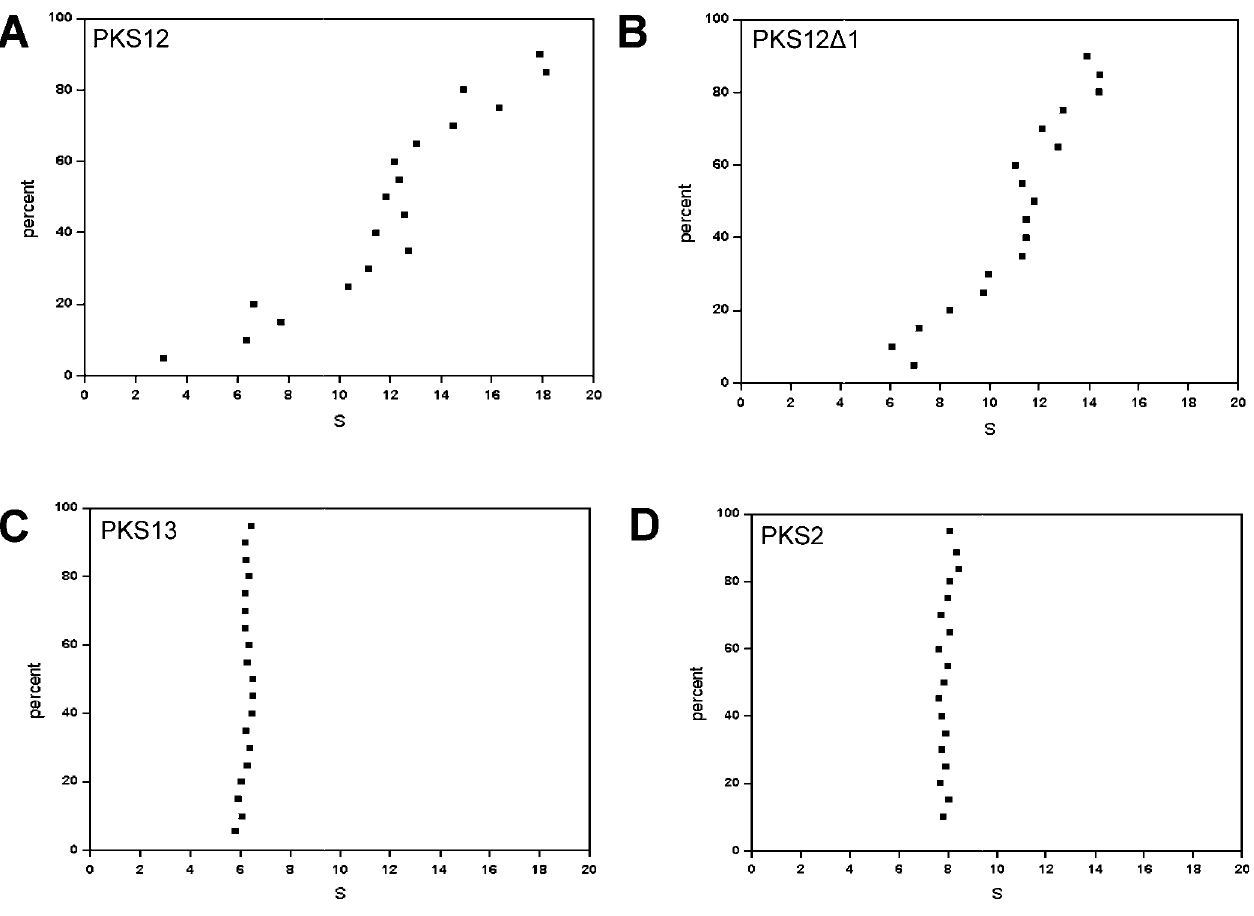
Figure 6. Sedimentation Velocity Analyses Analysis of PKS12 (A), PKS12 D 1 (B), PKS13 (C), and PKS2 (D) by sedimentation velocity in the XL1-analytical ultracentrifuge in 50 mM phosphate buffer (pH 7.2). The data were analyzed to yield the integral distribution of sedimentation